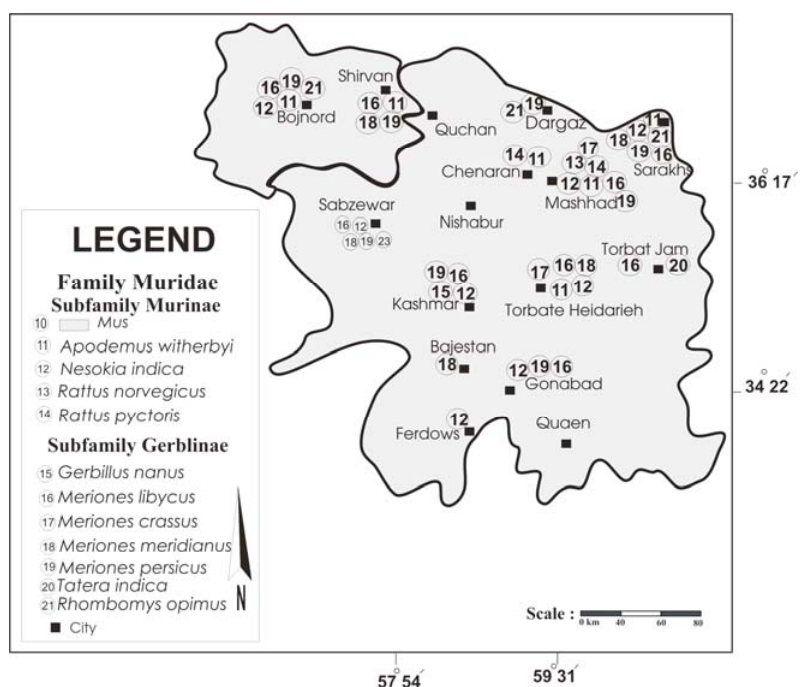
F IG . 4 . - Map of northeastern Iran with collecting sites for different species of Family Muridae, indicated with numbers (the numbers are the same as in text and tables